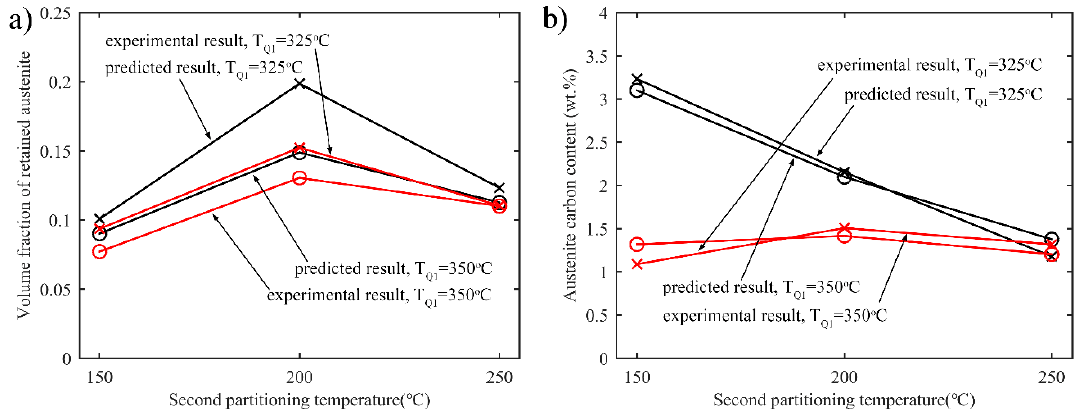
Figure 15. Comparison of the experimental and simulation results for retained austenite content and carbon content in austenite with various partitioning temperatures T Q1 and T Q2 . T P1 = 425 ◦ C. The first partitioning time is 10 s; T P2 = 350 ◦ C, and the second partitioning time is 10 s. ( a ) Volume fraction of retained austenite; ( b ) Carbon content in